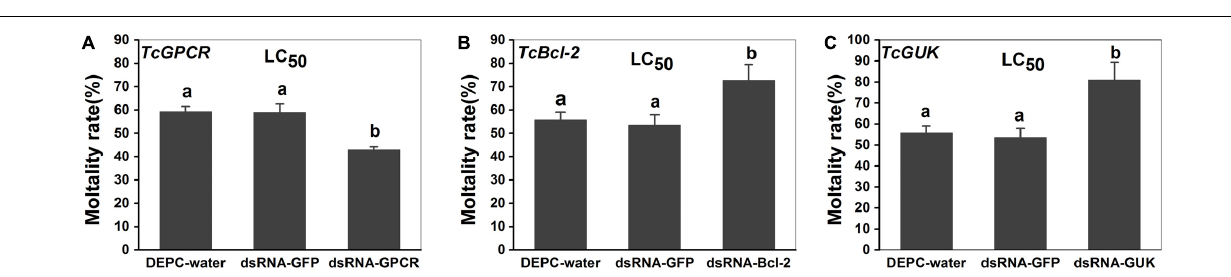
FIGURE 11 | Knockdown of TcGPCR expression reduced susceptibility to scopoletin, and knockdown of TcBAG and TcGUK expression increased susceptibility to scopoletin in mites, respectively. (A) Mortality of TcGPCR -silenced T. cinnabarinus to scopoletin at LC 50 . (B) Mortality of TcBAG -silenced T. cinnabarinus to scopoletin at LC 50 . (C) Mortality of TcGUK -silenced T. cinnabarinus to scopoletin at LC 50 . Error bars represent the standard error of the calculated mean based on three biological replicates. Different letters on the error bars indicate significant difference according to Duncan’s multiple tests (alpha = 0.05). i.e., No statistical